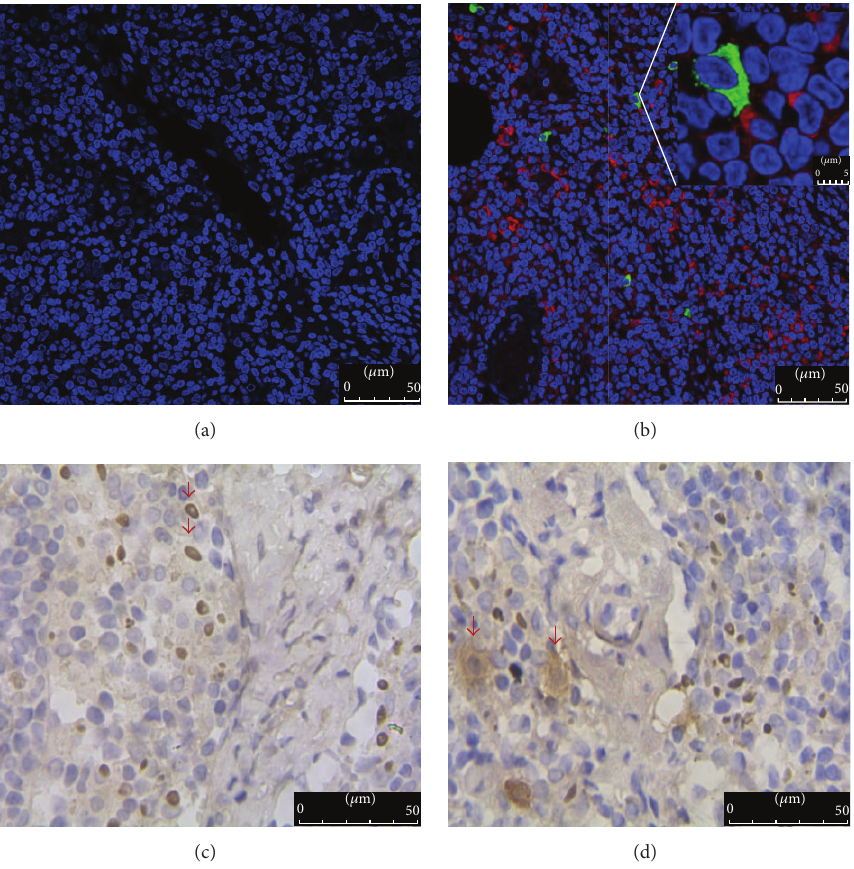
Figure 1: Location of mast cells and CD4 + T cells as well as their morphology in peritoneal lymph node. (a) As a negative control, the section of lymph node was incubated with PBS instead of primary antibody (200x); (b) mast cells (green, stained with antimast cell tryptase antibody) and CD4 + T cells (red, stained with anti-CD4 antibody) colocalized in the peritoneal lymph node, marked by the red arrows (200x); (c) as a control, the outline of CD4 + T cells is clear (400x); (d) mast cells are blurred and surrounded by tiny brown particles (400x). Scale bars are 50 𝜇 m. In this experiment, CD4 and tryptase are used to mark CD4 + T cells and mast cells, respectively.